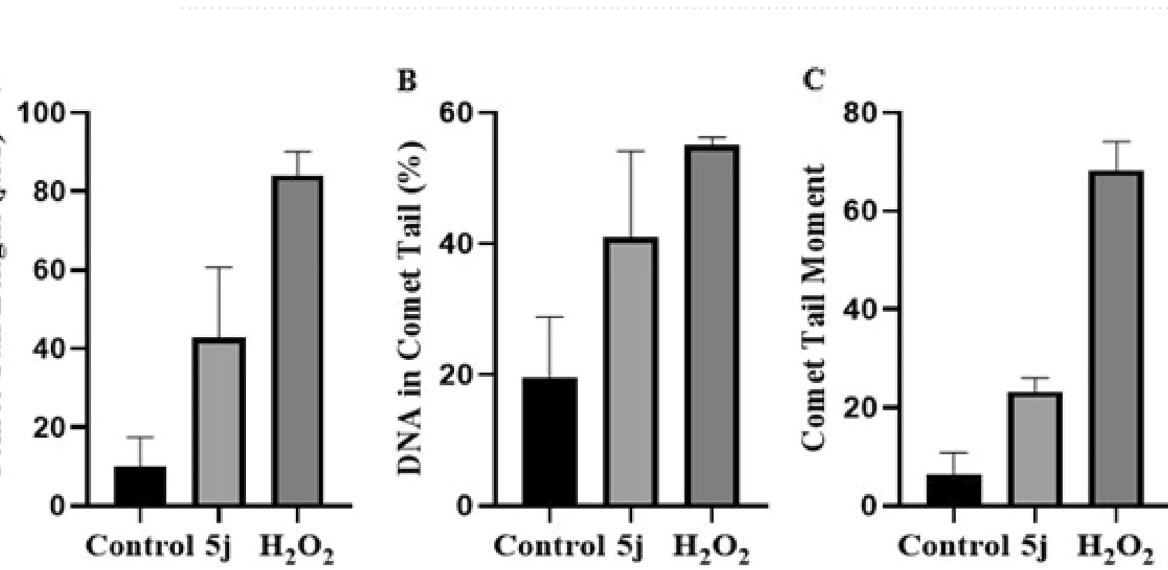
Table 3. DNA damage parameters calculated for compound 5j, untreated and H 2 O 2 treated cells. SD standard deviation.